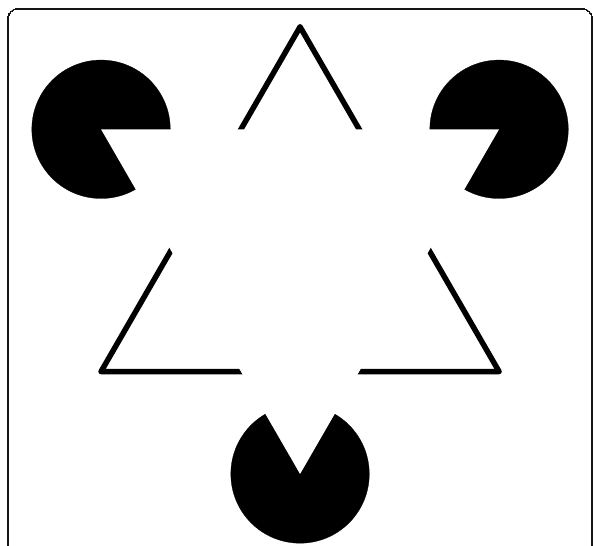
Fig. 1 Kanizsa triangle consisting of three discs, each of which is missing a triangular section, and three pairs of lines. Most humans will have the impression that there is an upright triangle with black edges and an inverted triangle with white edges, which do not really